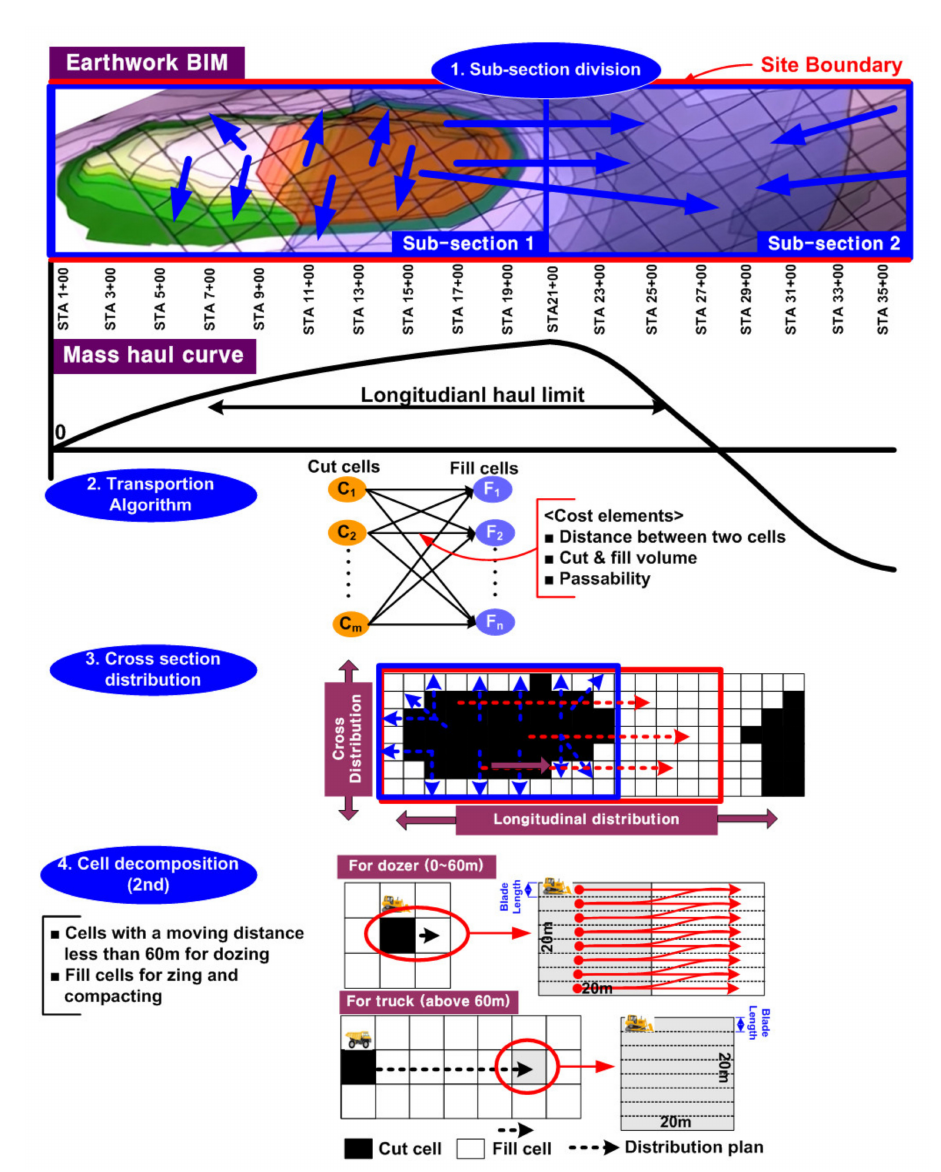
Figure 2. Site sub-division, soil distribution, and 2nd cell decomposition (c.f. Kim et al.,